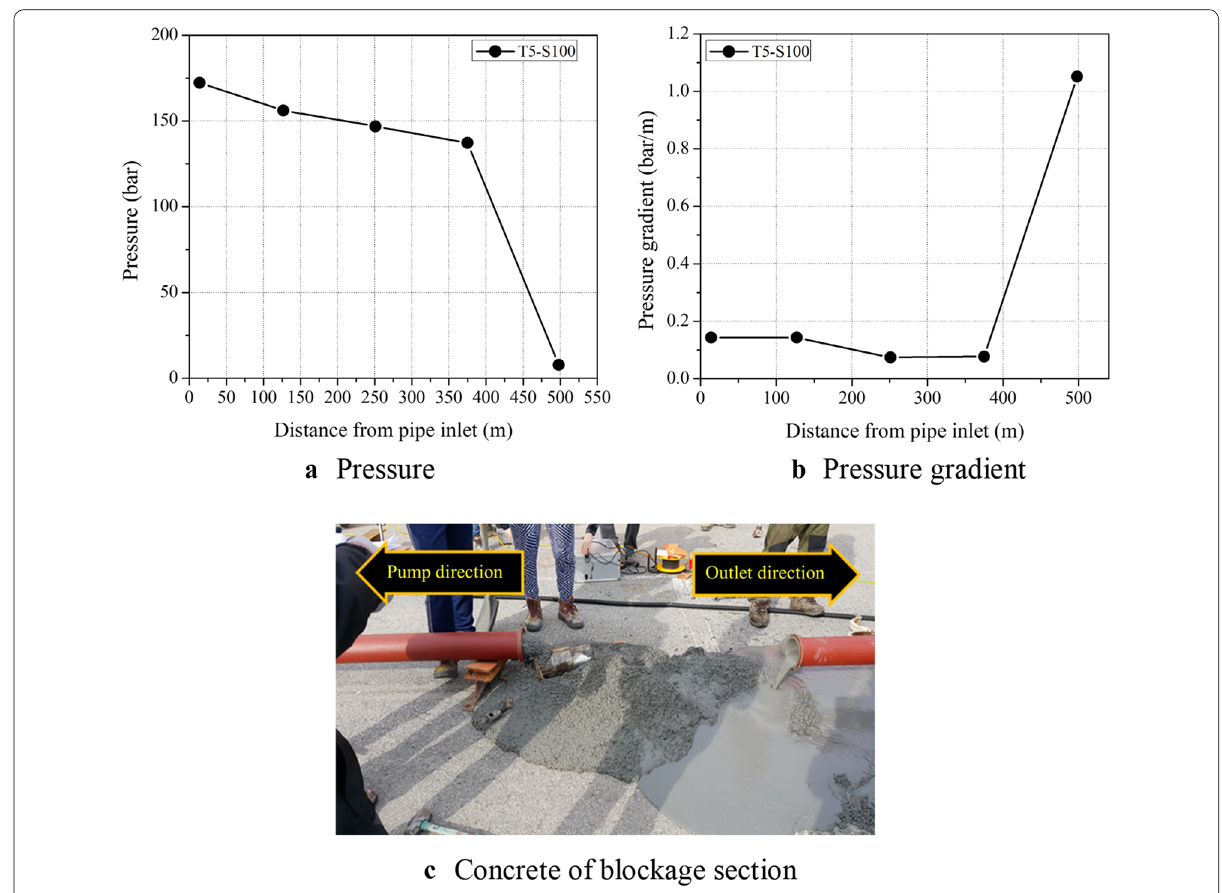
Fig. 11 Results of pressure and pressure gradient over the pipe length—blockage.